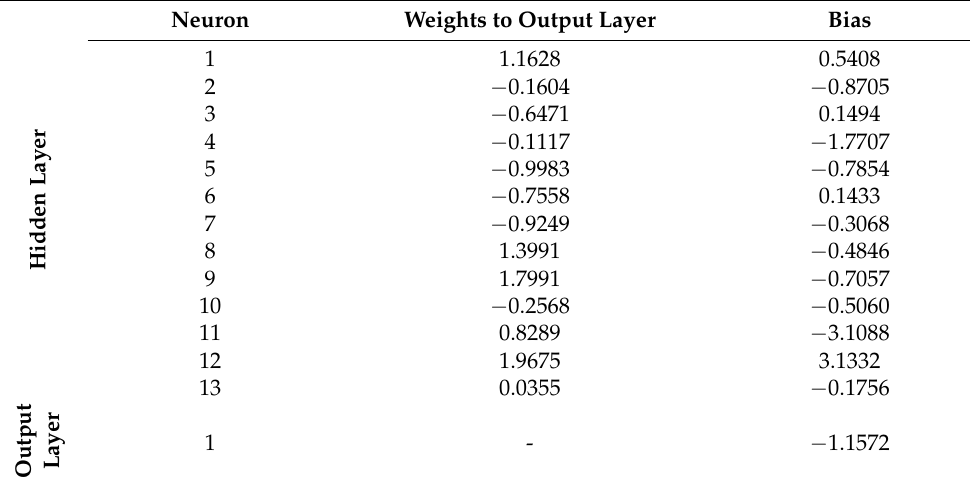
Table 4. The biases (b 1j , b 0 ) and weights (LW 1,j ) of hidden layer to output layer for the case